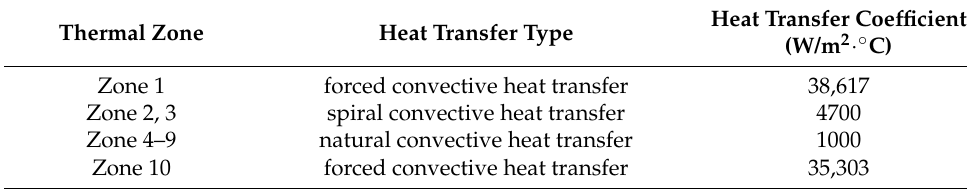
Table 2. The heat transfer coefficient of flow case 3.